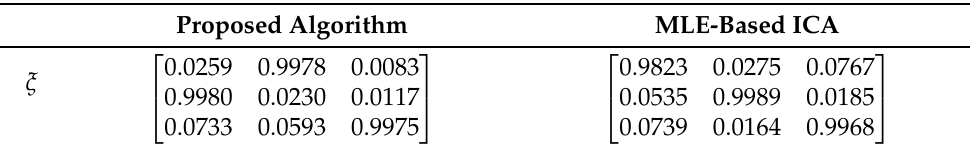
Table 4. Similarity coefficients of the proposed algorithm and the conventional MLE-based ICA algo-